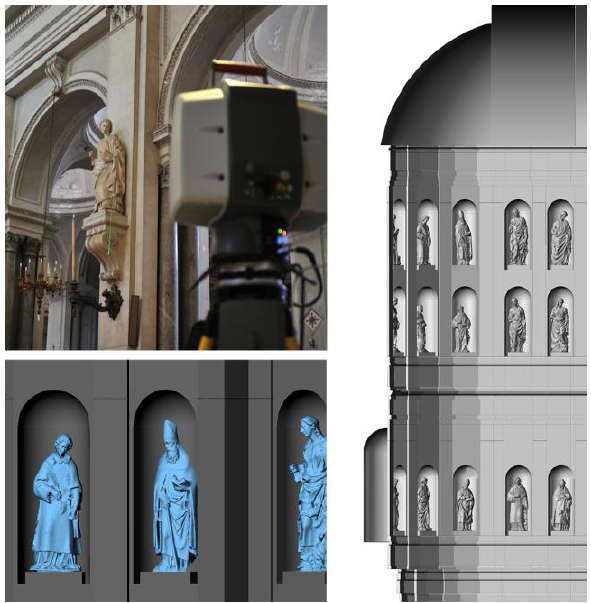
Figure 5: Polygonal model from laser scanning survey of the statues originally placed in the